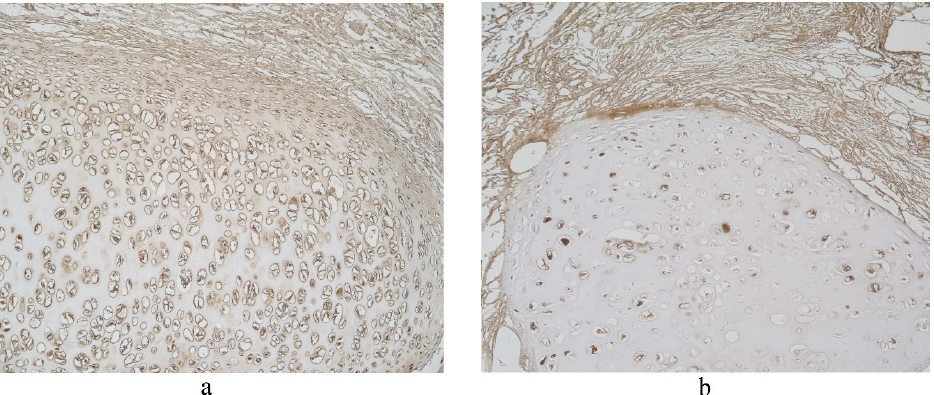
Figure 5. Immunohistochemical micrographs in lung tissue samples. ( a ) Numerous IL-17A positive cells in cartilage of 19-year-old male. IL-17A IMH, ×100; ( b ) moderate IL-17A positive structures in cartilage and none in connective tissue of 25-year-old male. IL-17A IMH, ×100.